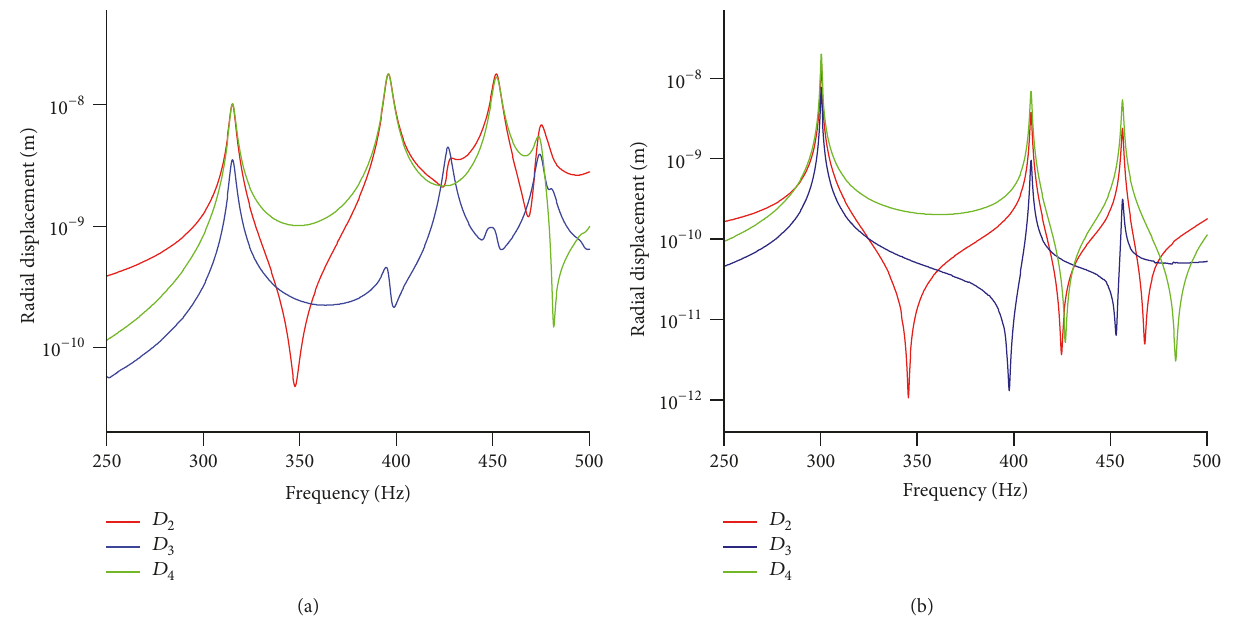
Figure 7: The radial displacements of the point 𝐷 2 , 𝐷 3 , and 𝐷 4 when the axial force 𝑓 𝑢 acts on the point 𝐷 1 of the ECE and PEC vessels: (a) ECE vessel, (b) PCE